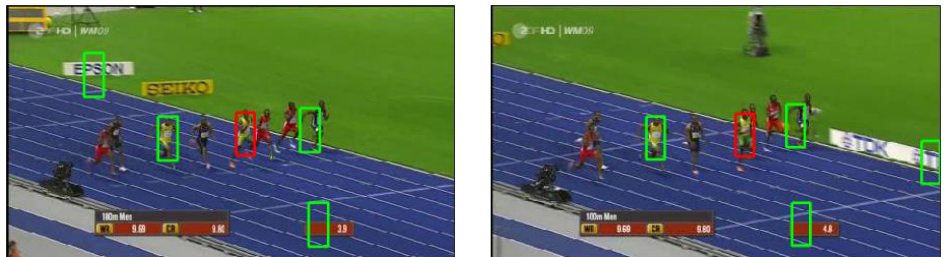
Figure 1. An illustration of template competition. The red rectangle area in the left image shows the template used for finding the matching location in the right image. The four same-sized green rectangle areas are the additional templates taken from the left image. These templates compete with each other to be matched to the right image. This competition means that only one template can be the best matching one at each location. The locations matching each template are shown on the